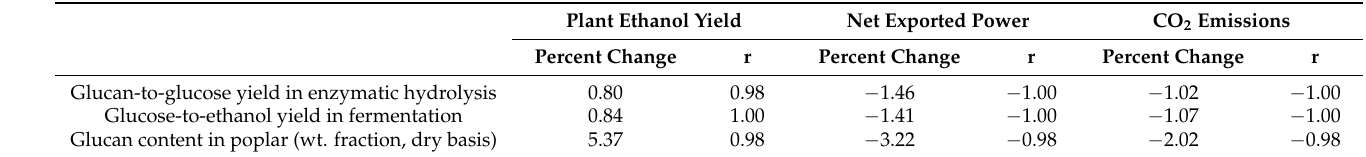
Table 5. Percent change in the plant ethanol yield, net power exported to the grid, and CO 2 emissions from a 1% change in the glucan-to-glucose yield, glucose-to-ethanol yield, and glucan content. A linear relationship was assumed; therefore, the Pearson coefficient is also presented.